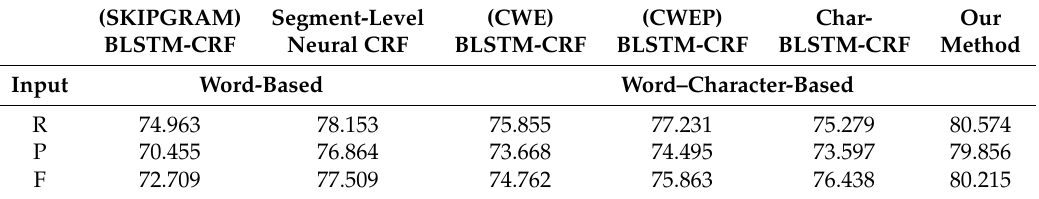
Table 3. Performance complexities.We used recall (R), precision (P) and the F-measure (F) to evaluate the